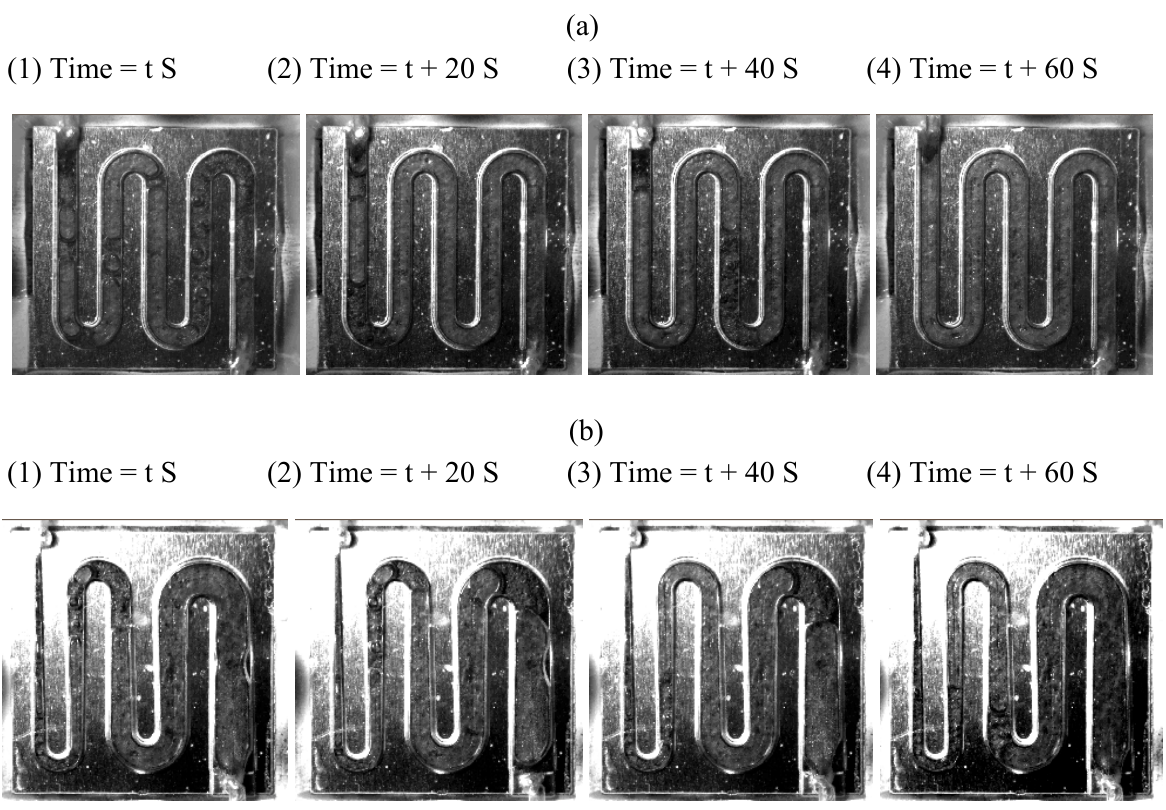
Table 2. The residual volume fraction of